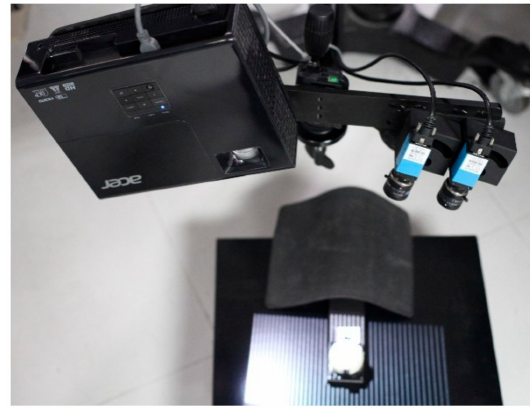
Figure 6. 3D measurement